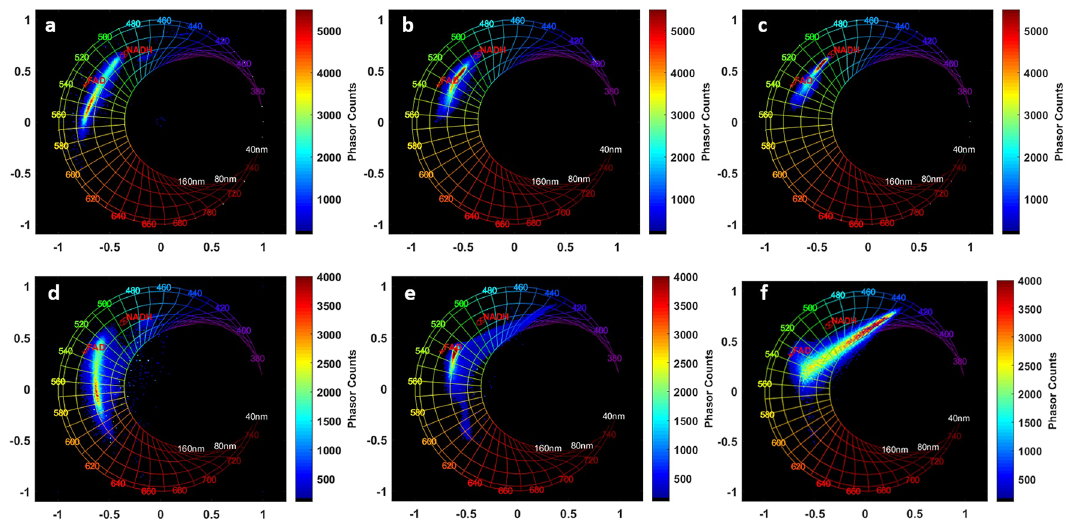
Figure 4. Spectral Phasor histograms using 810 nm ( a – c ) and 890 nm ( d – f ) for: Control ( a , d ), Grade I meningioma ( b , e ) and Grade II meningioma ( c , f